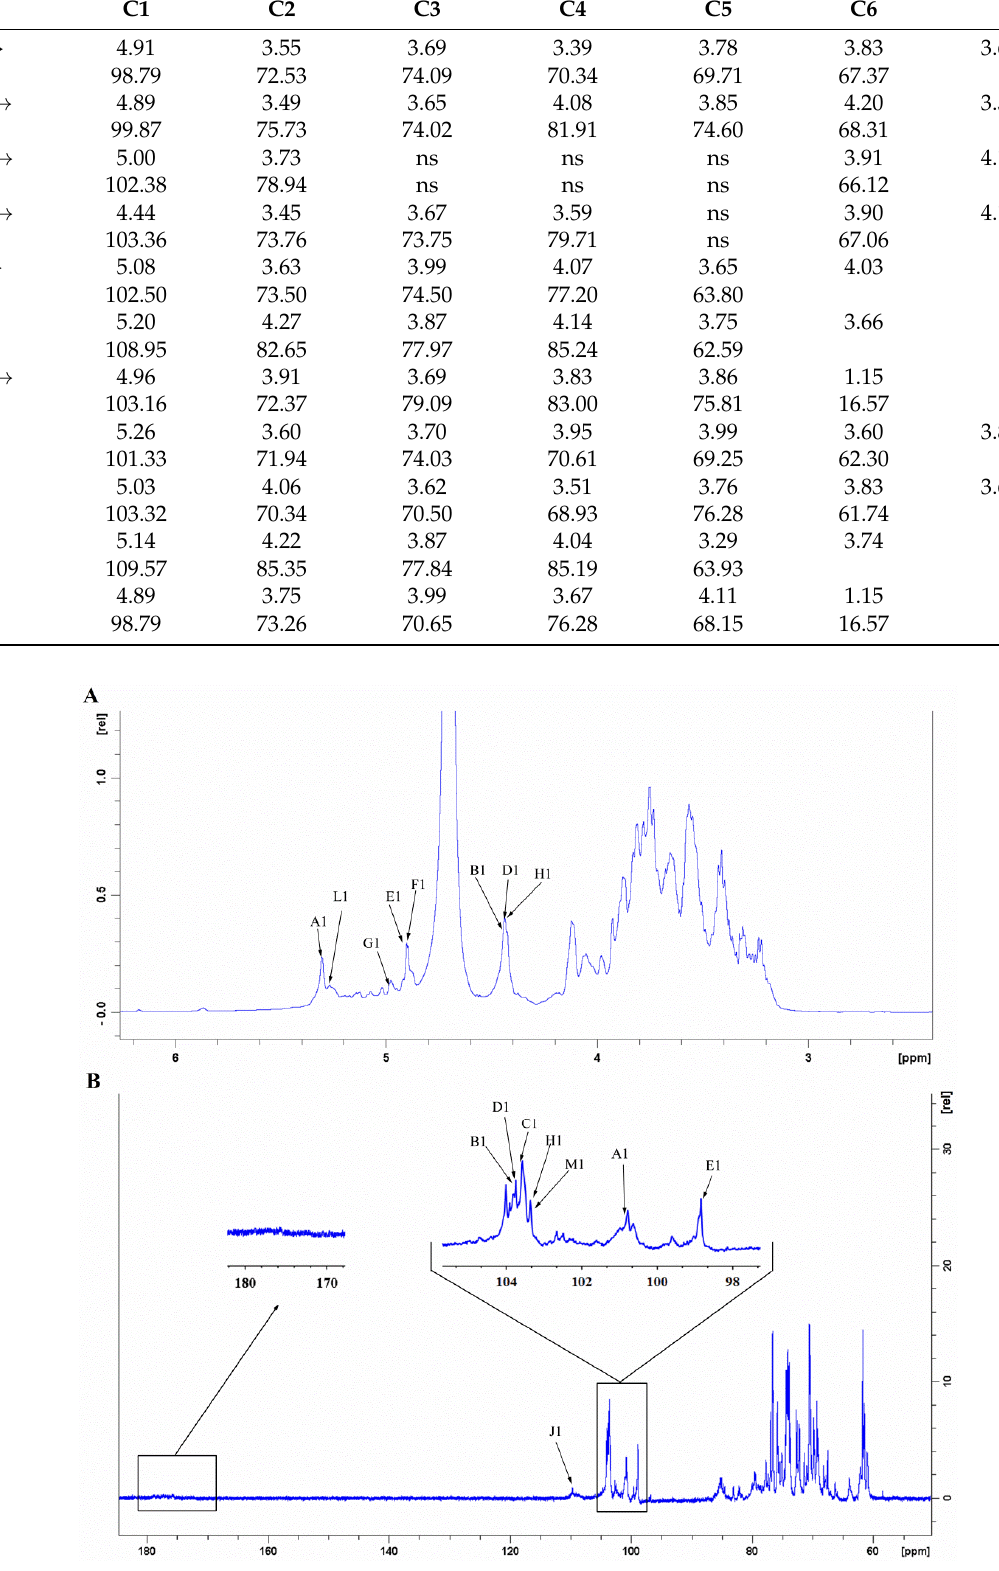
Figure 8. 1 H NMR ( A ) and 13 C NMR ( B ) spectra of GLP-1. The assignations of residue signals in 1 H and 13 C NMR spectra were further ana- lyzed by the 1 H- 1 H COSY and HSQC spectra. The residue A , namely → 4)- α -D-Glc p -(1 → , was taken as an example in this section. The cross-peaks 5.32/3.55 and 3.55/3.88 ppm were detected in the 1 H- 1 H COSY spectrum (Figure 9). Given that the signal at 5.32 ppm corresponded to the H-1 of residue A , 3.55 and 3.88 ppm were attributed to the H-2 and H-3 of residue A , respectively. Similarly, the signals at 3.58, 3.76, and 3.77 ppm were as- signed to the H-4, H-5, and H-6 of residue A . From the HSQC spectrum (Figure 10), the strong cross-peak H/C (5.32/100.66 ppm) revealed close connectivity between H-1 and C-1. The carbon peaks of C-2 (72.53 ppm), C-3 (74.25 ppm), C-4 (77.69 ppm), C-5 (72.22 ppm), and C-6 (61.43 ppm) were also found in the HSQC spectrum. Based on the above-mentioned analogy and the literature data, the C/H chemical shifts of all residues were confirmed and are presented in Table 3 [24,34,64–67].